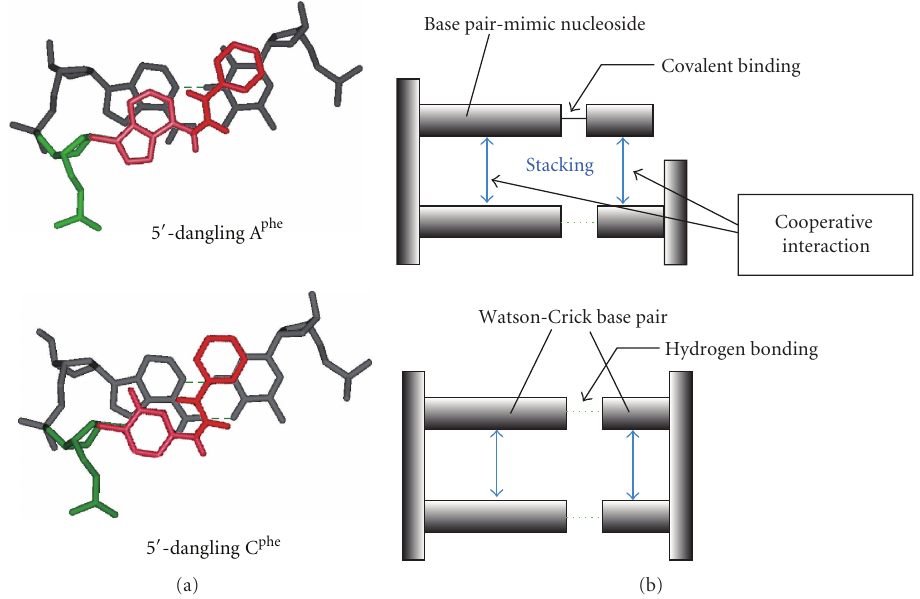
Figure 5: (a) Stacking conformations of the dangling A phe and C phe (colored in red) at the 5 (cid:2) -end of a DNA duplex. (b) Side view of the DNA double helix, representing the interaction mechanism of the dangling end stacking (upper) and the Watson-Crick base pairing (lower). Cooperative interaction in the base pair-mimic nucleoside is suggested between stacking of the base moiety and stacking of the nonpolar